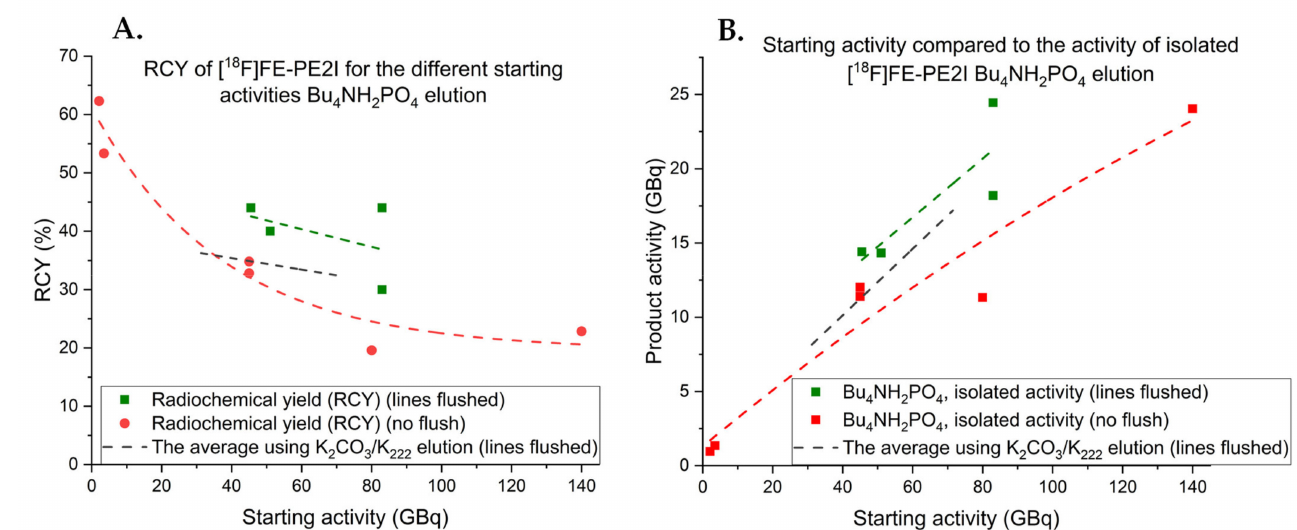
Figure 8. ( A ) Isolated RCY of [ 18 F]FE-PE2I in relation to the starting activity of fluorine-18 with the Bu 4 NH 2 PO 4 elution method. ( B ) Comparing the activity of isolated [ 18 F]FE-PE2I to the starting activity of fluorine using the Bu 4 NH 2 PO 4 elution method. The exponential fit from the K 2 CO 3 /K 222 elution method is added for